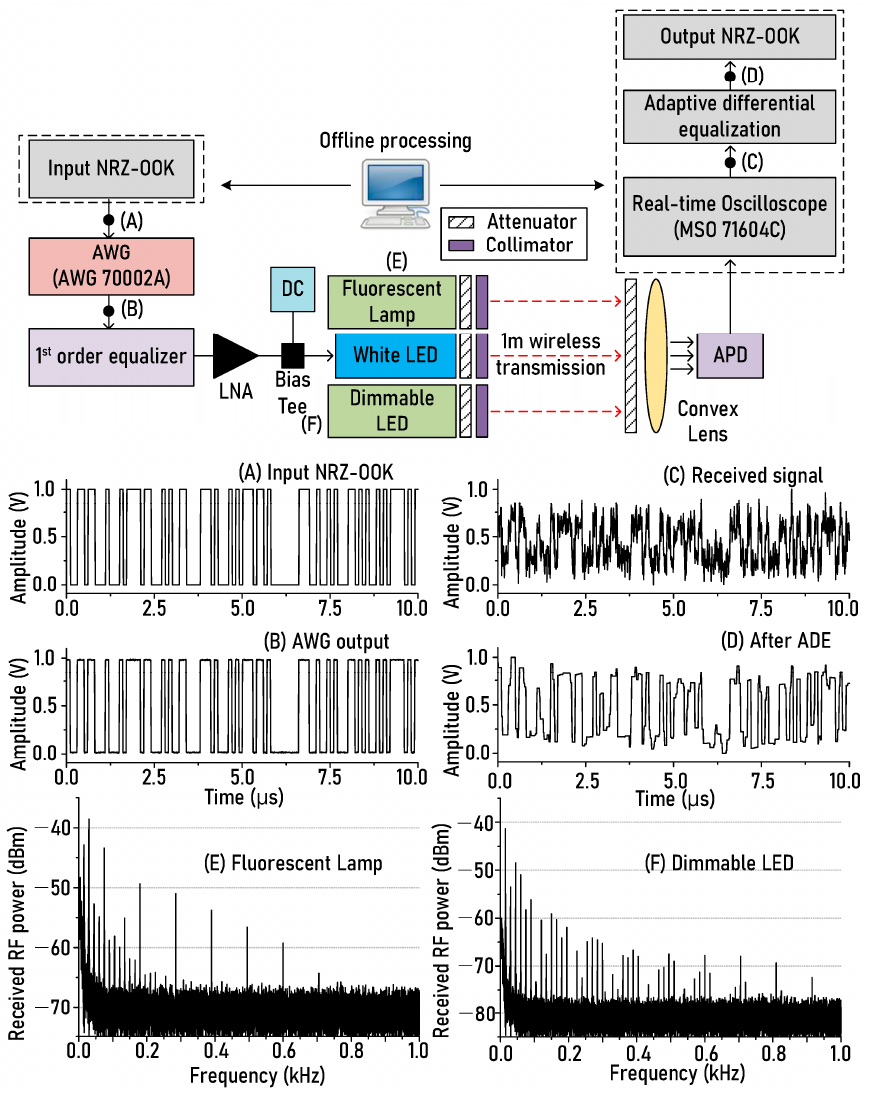
Figure 2. Optical wireless transmission link based on white light − emitting diode (LED) for the verification of adaptive differential equalization (ADE) technique. Insets below experimental setup: ( A ) in- put non − return − to − zero − on − off keying (NRZ-OOK) waveform, ( B ) output NRZ − OOK waveform from arbitrary waveform generator (AWG), ( C ) NRZ − OOK waveform received at avalanche pho- todiode (APD), ( D ) NRZ − OOK waveform after using the proposed ADE technique, ( E ) RF(radio frequency) spectrum of fluorescent lamp, ( F ) RF spectrum of dimmable